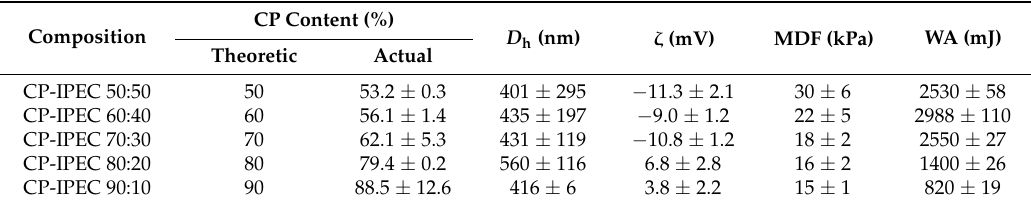
Table 5. Characterization of clobetasol propionate (CP) loaded into IPEC formed by NAA-1 and EPO in the ratio 33:67 %.